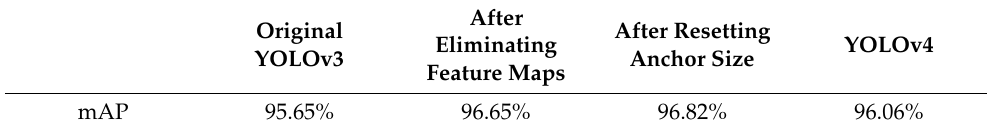
Table 6. mAP comparison with different improvements and YOLOv4. After After Resetting Original Eliminating Anchor Size YOLOv3 Feature Maps mAP 96.06%